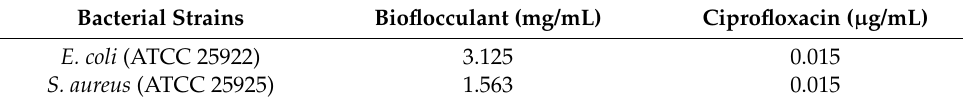
Table 6. MIC values of the bioflocculant against the test